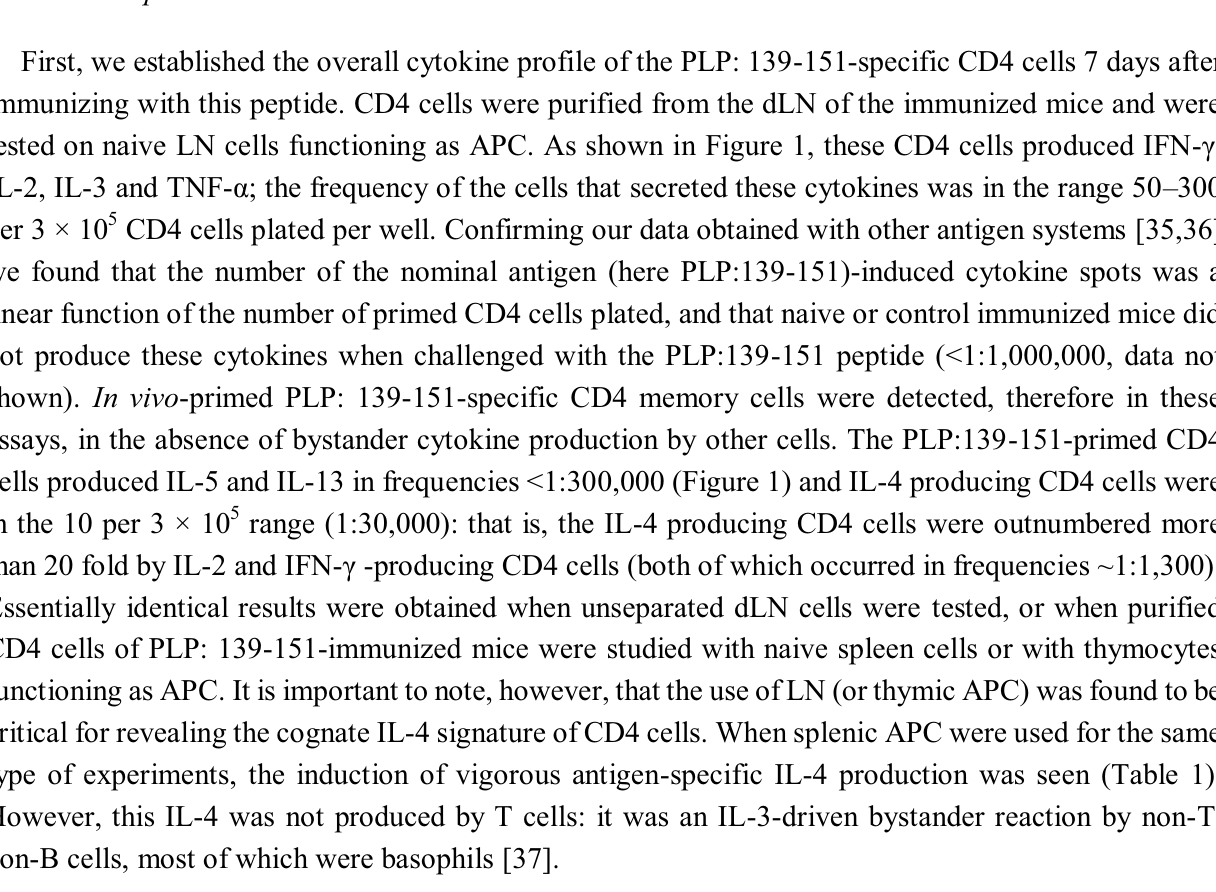
Figure 1. Overall type-1 cytokine profile of proteolipid protein (PLP):139-151-specific CD4 cells 7 days after the immunization with PLP:139-151. CD4 cells (3 × 10 5 /well) purified